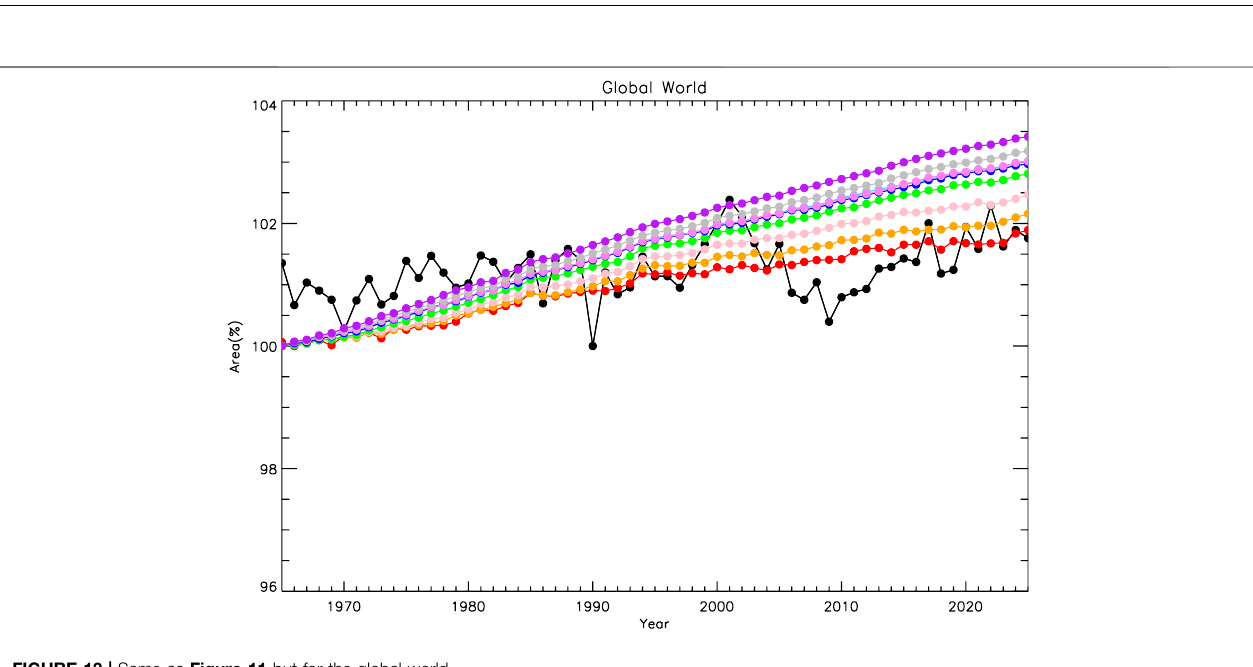
FIGURE 12 | Area time change rate of EPWs corresponding to different rigidities obtained by polynomial fi tting.